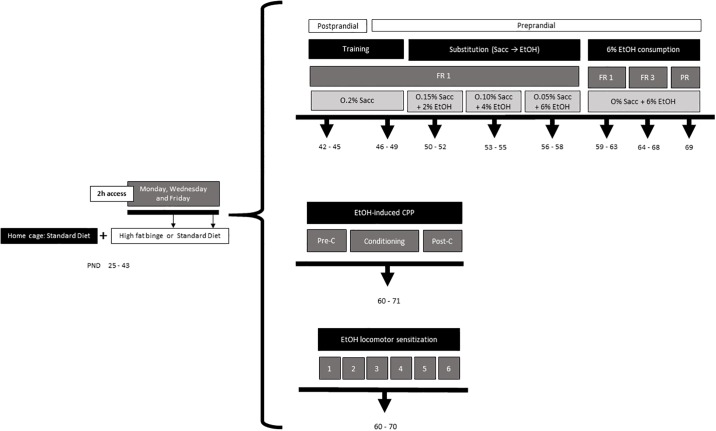
Experimental design.